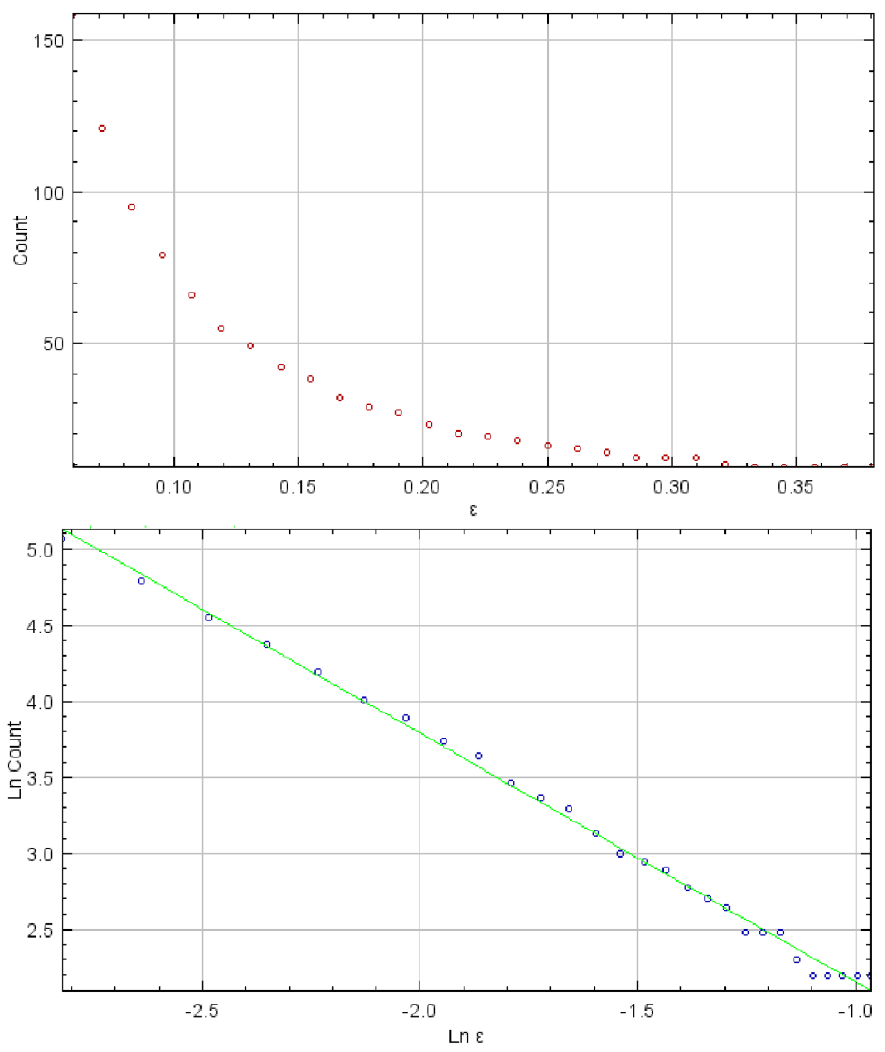
Figure 3. The fractal dimension of ROIs was calculated based on the slope of the regression line of log(1/ε) versus log N(ε) for all scales. The value of the fractal dimension in this example is 1.6142. The standard deviations for the experimental and control groups of cells were 0.155 and 0.142, respectively.